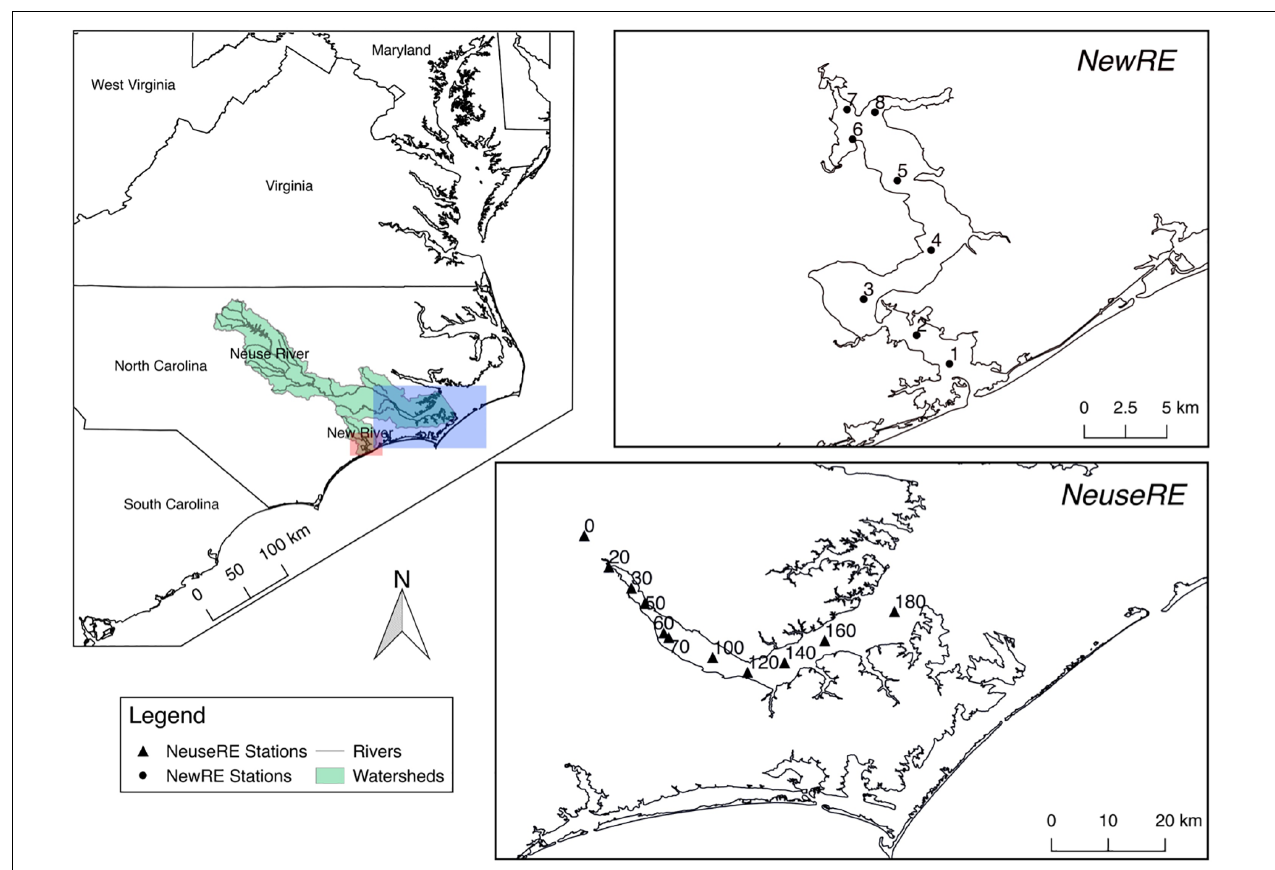
FIGURE 1 | Site map, including sampling stations for both estuaries, and watershed extents for both